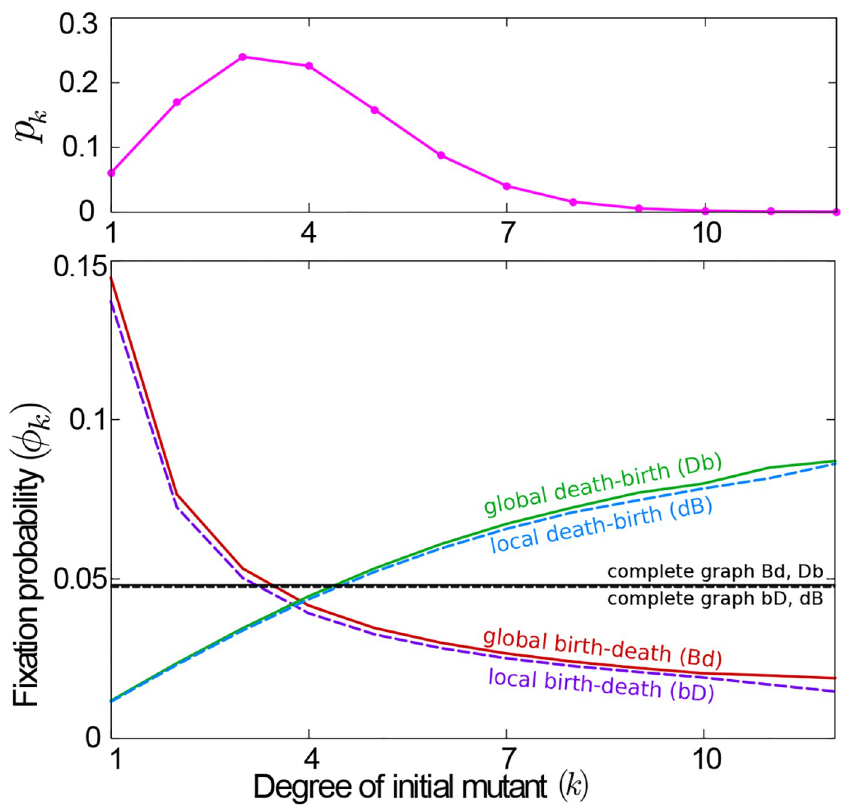
Fig 4. Significance of the degree of the initial mutant. The upper panel shows the degree distribution, p k , of the ensemble of connected random geometric graphs (CRGGs), obtained by placing N = 100 individuals into the spatial domain 0 � x , y � 1 with uniform distribution, and using an interaction radius R = 0.11 and periodic boundary conditions. The lower panel shows the fixation probability obtained from simulating the evolutionary process on these graphs, as a function of the degree of the initial mutant. For the two death-birth processes the mutant’s success is below the one on a complete graph if its degree is low, and above ϕ CG at high connectivity. The reverse is found for the two birth-death processes. Data points have been connected as a visual